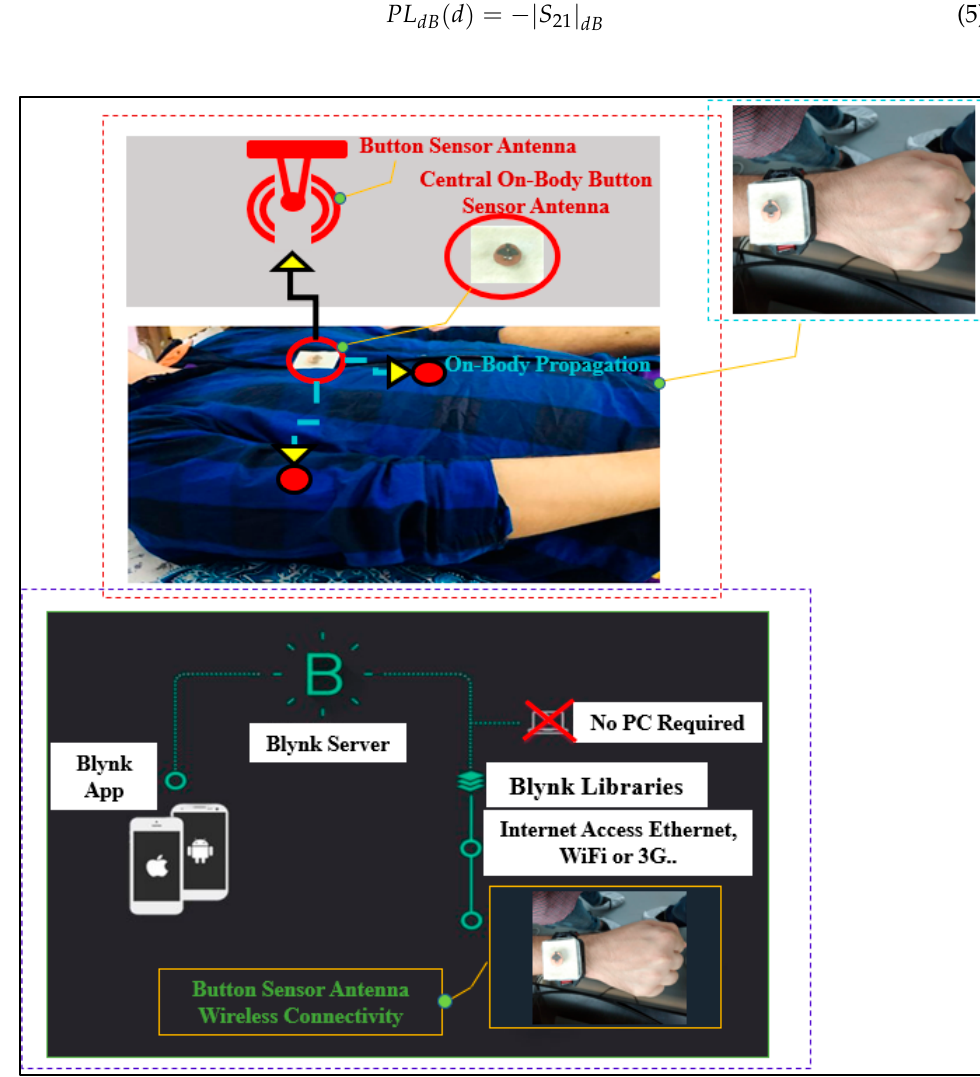
Figure 25. Measurement scenarios of wireless connectivity setup for on-body communication.